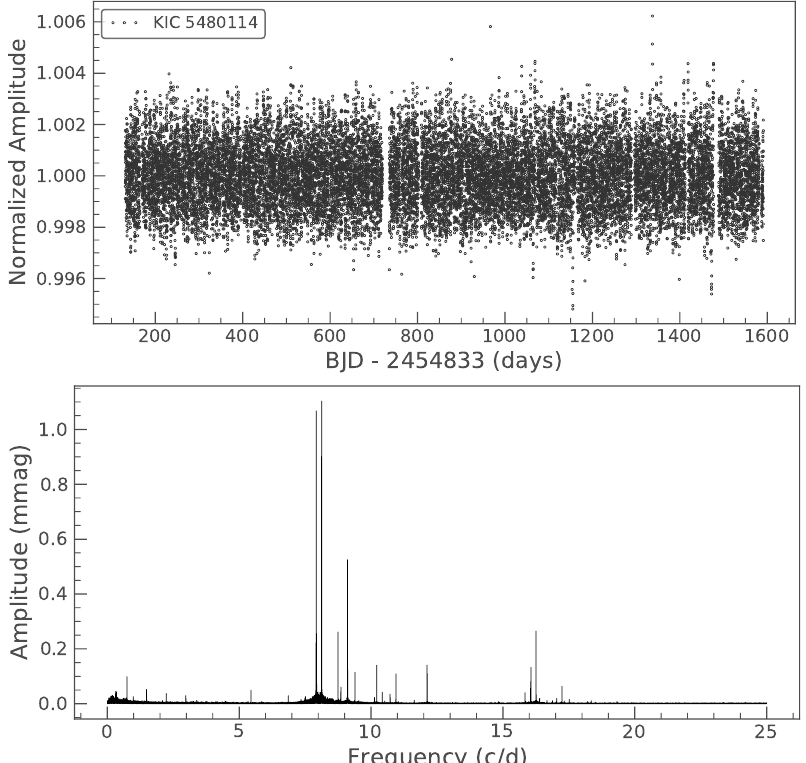
Figure 6. Normalized detrended light curve ( top ) and frequency spectrum ( bottom ) of KIC 5480114.